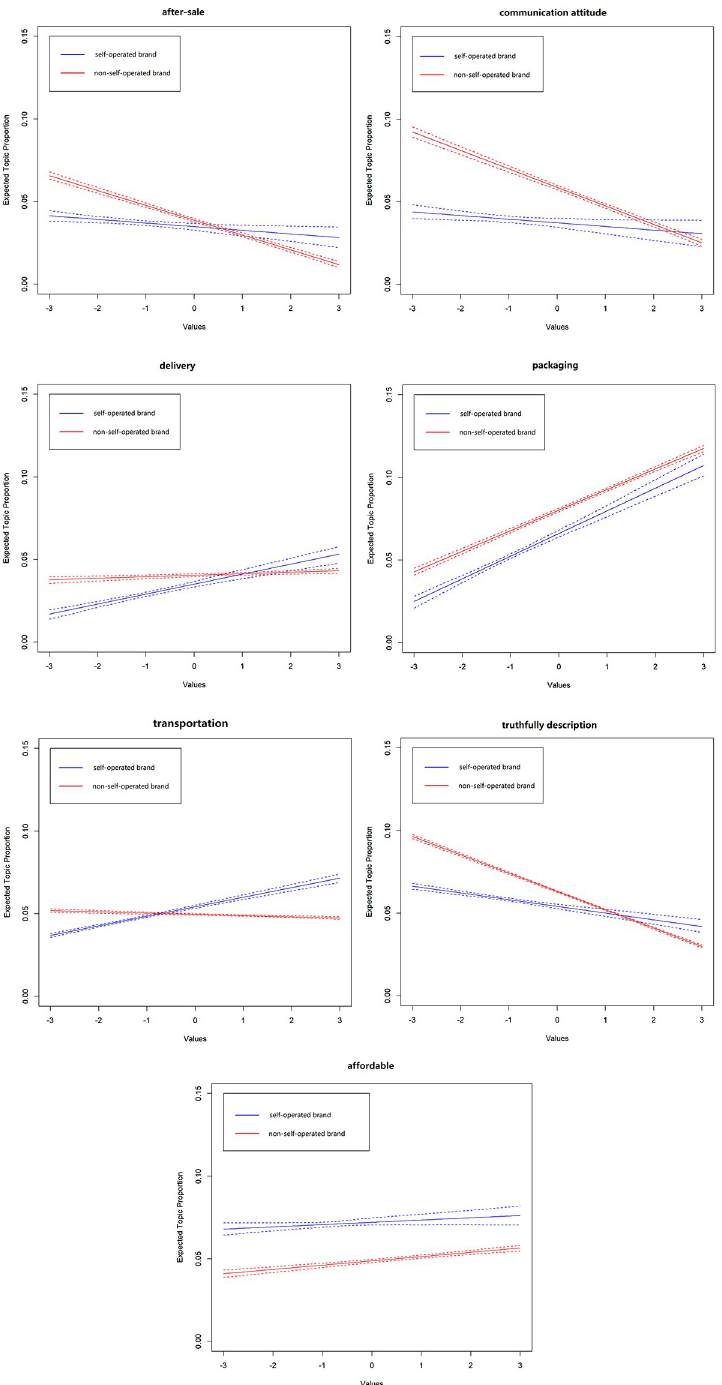
Fig 6. Moderating effects of review sentiment